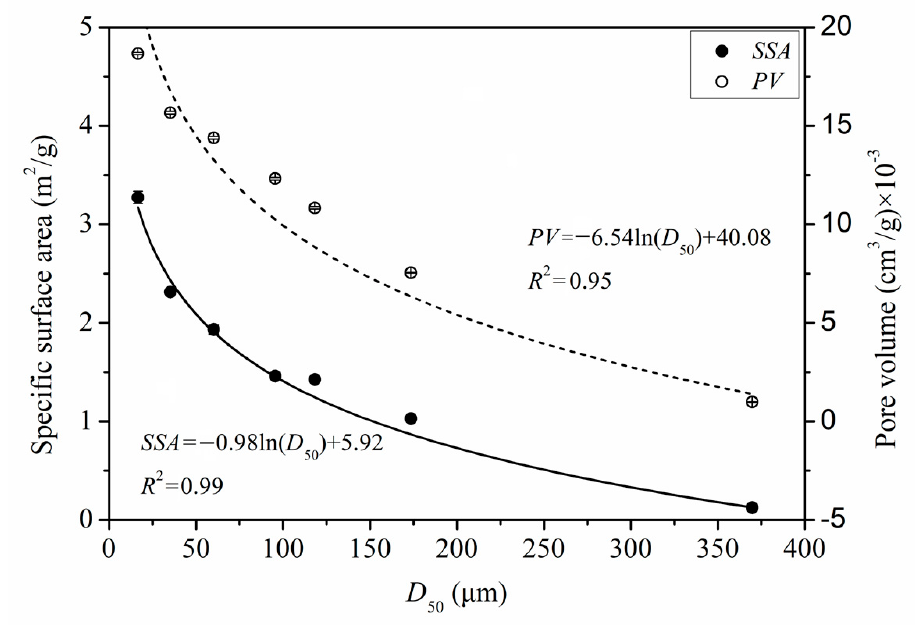
Figure 3. Quantitative relationships of SSA , PV , and D 50 of PIDF.